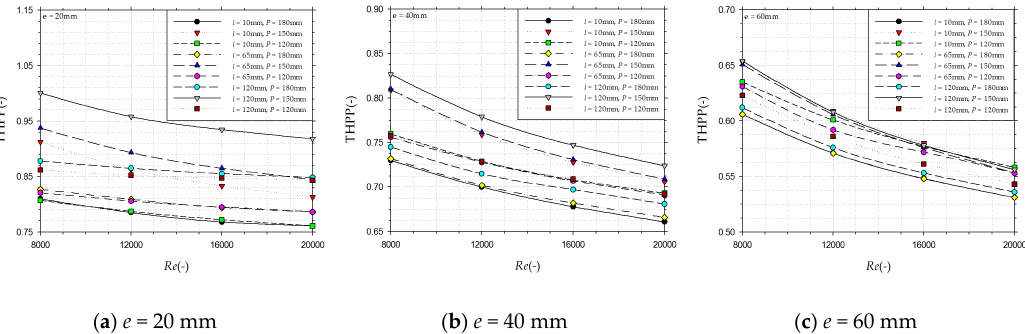
Figure 14. Variation of THPP for different value of pitch ( P ), length ( l ), and for a fixed value of height ( e ) with Reynolds number.